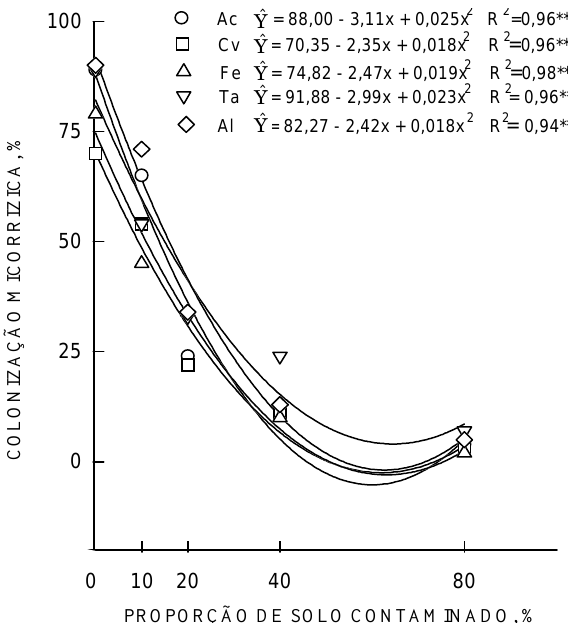
Figura 1. Colonização micorrízica do açoita-cavalo (Ac); cássia verrugosa (Cv); fedegoso (Fe); tamboril (Ta) e albizia (Al) após o transplantio para mistura com diferentes proporções de solo